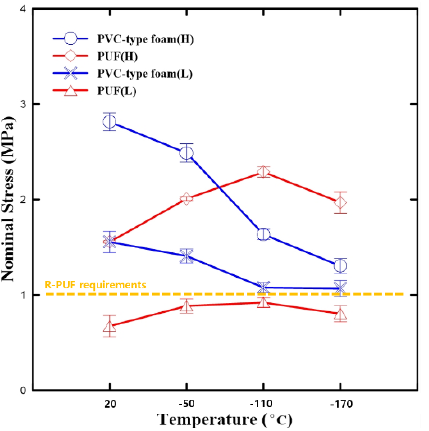
Figure 9. Nominal stress vs. temperature diagram comparing the tensile strengths of PVC-type foam and the PUF specimens with respect to R-PUF requirements at low and high temperatures.